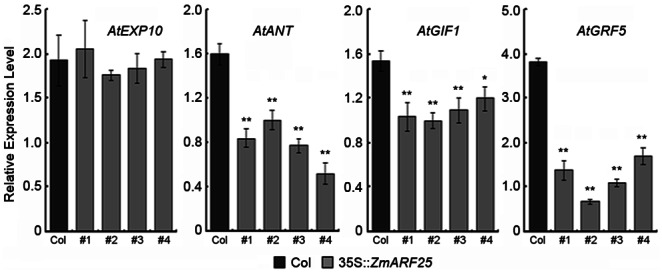
Expression patterns of organ size related genes in 35S::ZmARF25 and wild-type plants.The aerial portions of 15-day-old seedlings were used for qRT-PCR analysis. ACTIN 2 was used as the endogenous control. Col represents the wild-type; #1–4 represents the four 35S::ZmARF25 transgenic lines. Data are represented as the mean ± SE (n = 3). t-test compared with the wild-type control: *refers to significant at p<0.05, **refers to significant at p<0.01.